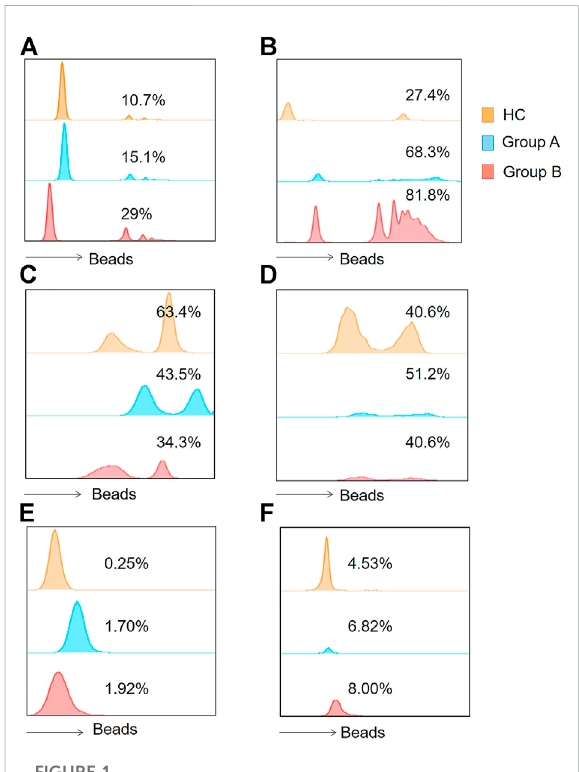
FIGURE 1 Histograms of fl ow cytometry were applied to represent the functions of the two immune cells. (A) Indicates the phagocytic function of neutrophils. (B) Indicates monocyte phagocytic function. (C) Represents the neutrophil ROS production results. (D) Represents monocyte ROS production results. (E) Represents neutrophil intracellular TNF- α production proportions. (F) Indicates monocytic intracellular TNF- α production proportions. Group A indicates the cohort of patients aged ≥ 65 years. Group A indicates the cohort of patients aged < 65 years. Tumor Necrosis Factor- alpha, TNF- α ; Reactive Oxygen Species, ROS.